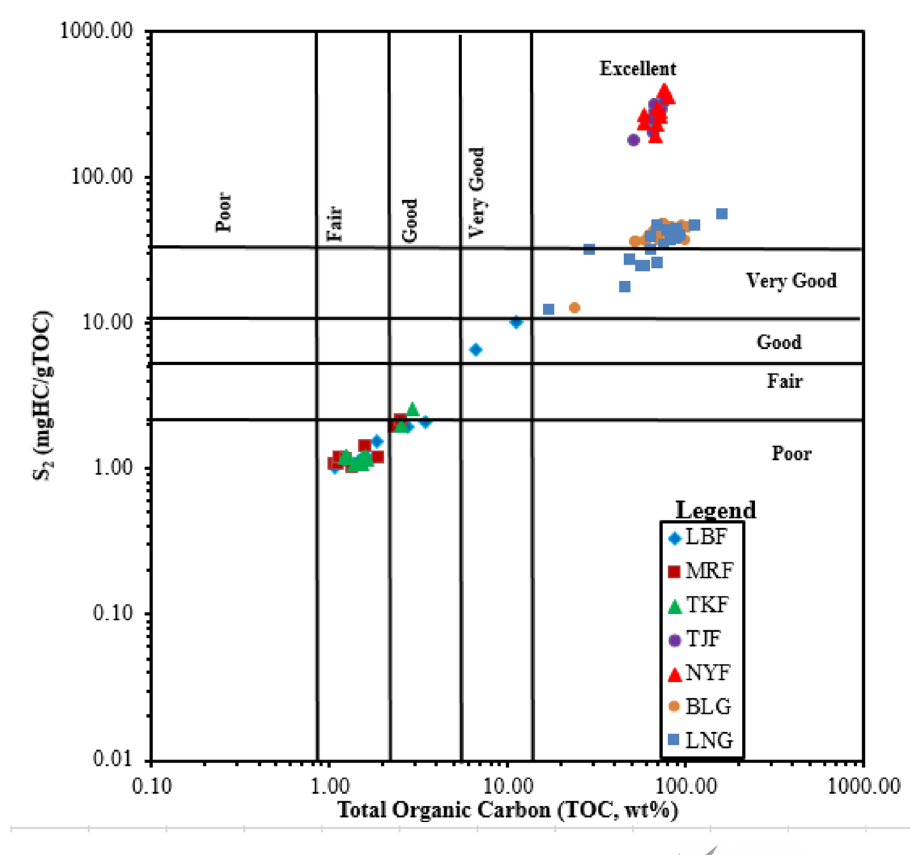
Fig. 8 Plot of S 2 agains TOC (wt%) for the onshore Sarawak source rock ( n = 95)